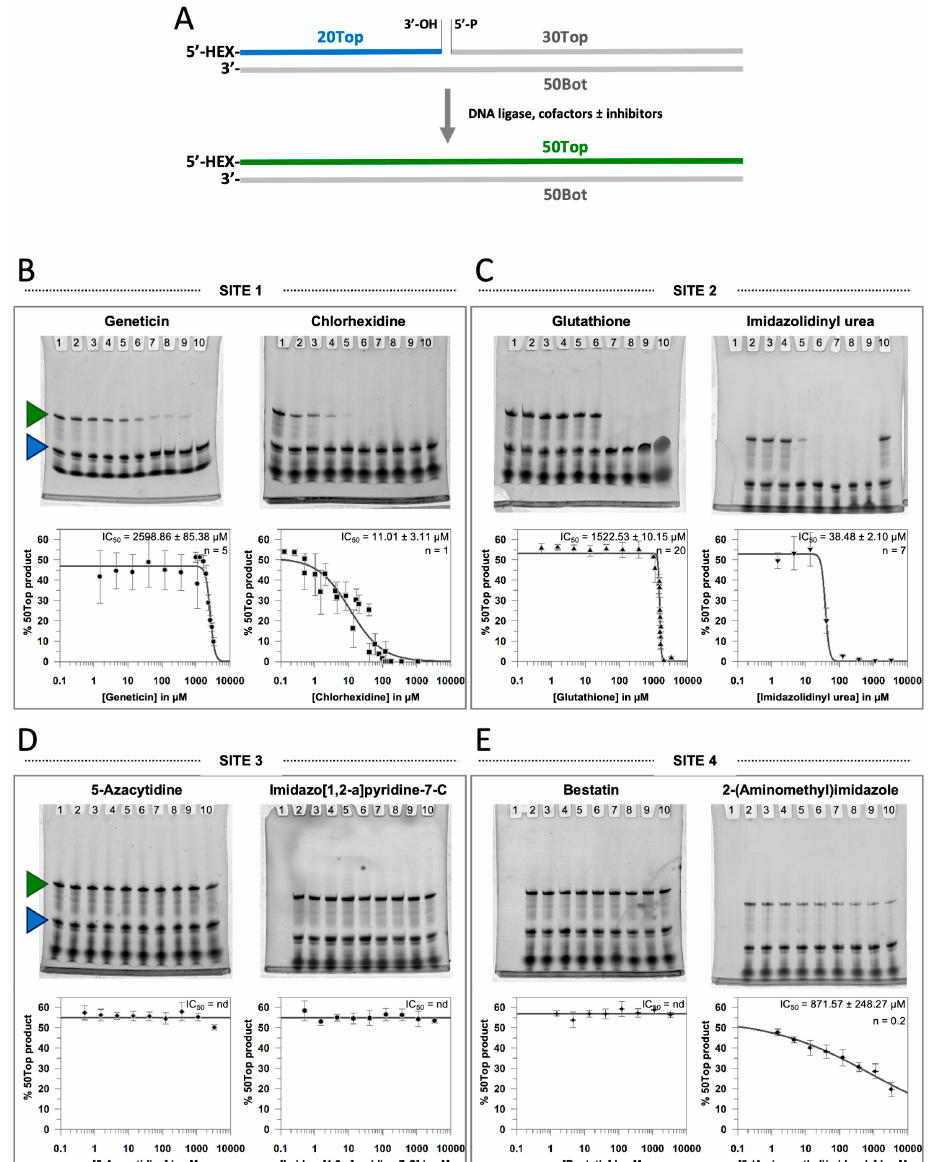
Figure 4. In vitro screening of candidate EC-LigA small molecule inhibitors. ( A ) A schematic of the in vitro ligation assay. A 50 bp nicked DNA substrate was prepared by annealing a 5 (cid:48) hexachlorofluorescein (HEX) labelled, 3 (cid:48) hydroxyl 20 nt single stranded oligonucleotide (20Top, blue) and an unlabelled, 5 (cid:48) phosphate 30 nt single stranded oligonucleotide (30Top) to a complementary unlabelled 50 nt single stranded oligonucleotide (50Bot). Subsequent ligation of 20Top and 30Top, by EC-LigA produced a 50 bp double stranded DNA product comprising 5 (cid:48) HEX labelled 50 nt DNA (50Top, green) and the complementary unlabelled 50 nt DNA 50Bot. ( B ) Representative 10% ( w / v ) denaturing PAGE of in vitro ligase assays performed with 120 nM nicked DNA substrate, 30 nM EC-LigA and 26 µ M NAD + in reaction buffer (30 mM Tris HCl, pH 8.0, 4 mM MgCl 2 , 1 mM DTT, and 50 µ g/mL BSA) in the presence of increasing concentrations of geneticin (0–3333 µ M) or chlorhexidine (0–3333 µ M) at room temperature for 5 min. Blue and green triangles mark the HEX labelled 20Top (substrate) and 50Top (product) DNA species, respectively. Gels were quantitated using ImageJ and the mean percentage 50Top DNA product was plotted against small molecule concentration. Error bars represent the standard error of the mean for a minimum of two experimental repeats. All data points were simultaneously fitted to a three-parameter IC 50 inhibition function (black line) to determine the IC 50 and n , which are reported in the top right corner of the plots. ( C ) As for ( B ) but for increasing concentrations of glutathione (0–3333 µ M) or imidazolidinyl urea (0–3333 µ M). ( D ) As for ( B ) but for increasing concentrations of 5-azacytidine (0–3333 µ M) or imidazo[1,2-a]pyridine-7-C (0–3333 µ M). ( E ) As for ( B ) but for increasing concentrations of bestatin (0–3333 µ M) or 2-(aminomethyl)imidazole (0–3333 µ